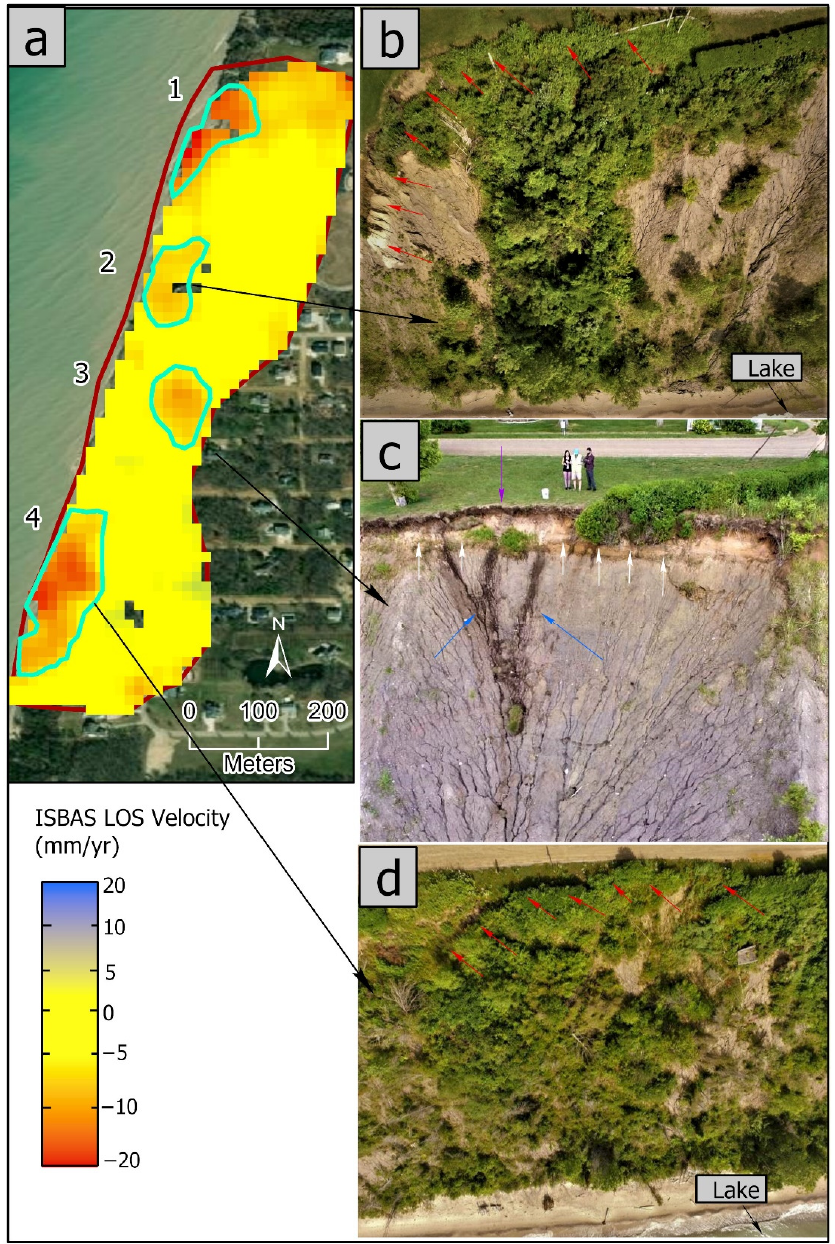
Figure 6. Oblique UAV acquisitions in 2017 (Figure 6b,d) and 2019 (Figure 6c) over anomalies 2, 3, and 4. ( a ) ISBAS LOS velocity map over the study area showing the distribution of anomalies 1, 2, 3, and 4 (green polygons). ( b ) UAV image over anomaly 2 showing small scarps (<50 cm) along the bluff face and proximal to its crest (red arrows). ( c ) Groundwater discharge (blue arrows) at the interface of a clay ‐ rich layer (thickness: 0.72 m) underlying a sandy soil layer (thickness: 0.9 to 1.2 m). ( d ) Well ‐ developed curvilinear crack (length: ~19 m) at the upper reach of the bluff face and multiple smaller, yet visible, subparallel curvilinear cracks downslope from it (red arrows). Source of ArcGIS pro base map in Figure 6a: Esri, DigitalGlobe, GeoEye, i ‐ cubed, USDA FSA, USGS, AEX, Getmapping, Aerogrid, IGN, IGP, swisstopo, and the GIS User Community.